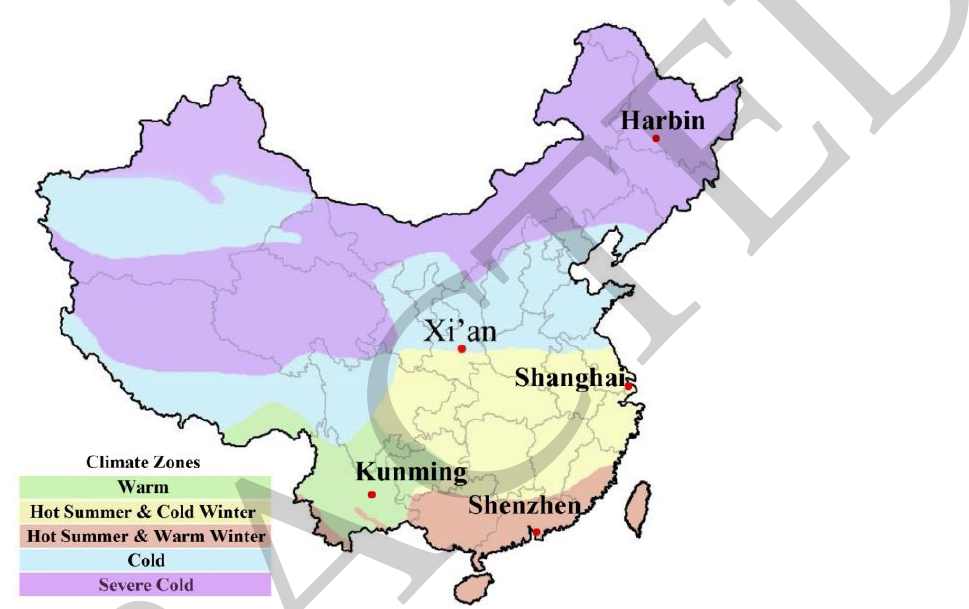
Figure 6. Five typical cities in five climate zones in this study. Data are obtained from the “ Standard of climatic regionalization for architecture ” (GB